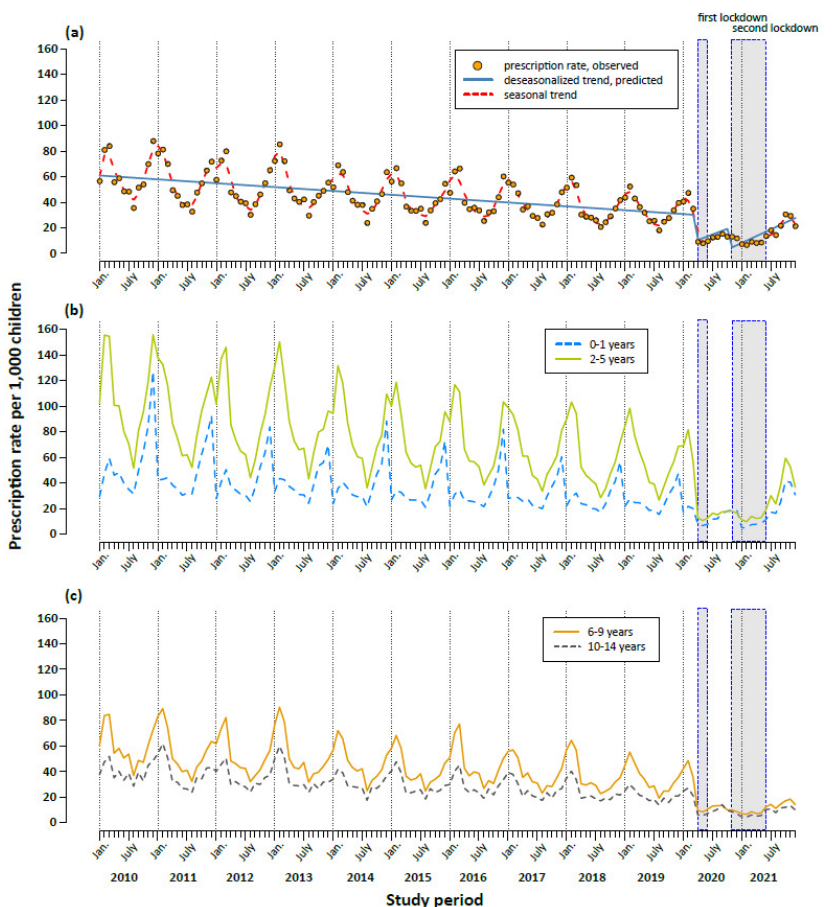
Figure 1. Trends in monthly antibiotic prescription rates per 1000 children aged between 0 and 14 years ( a ) and by age group ( b , c ) in the period 2010 to 2021. The first lockdown was introduced on 23 March 2020 and comprised extensive contact restrictions. The second, so-called lockdown light, started on 2 November 2020. ( a ) Solid line: predicted deseasonalized trend, dashed line: seasonal trend estimated with cubic spline.